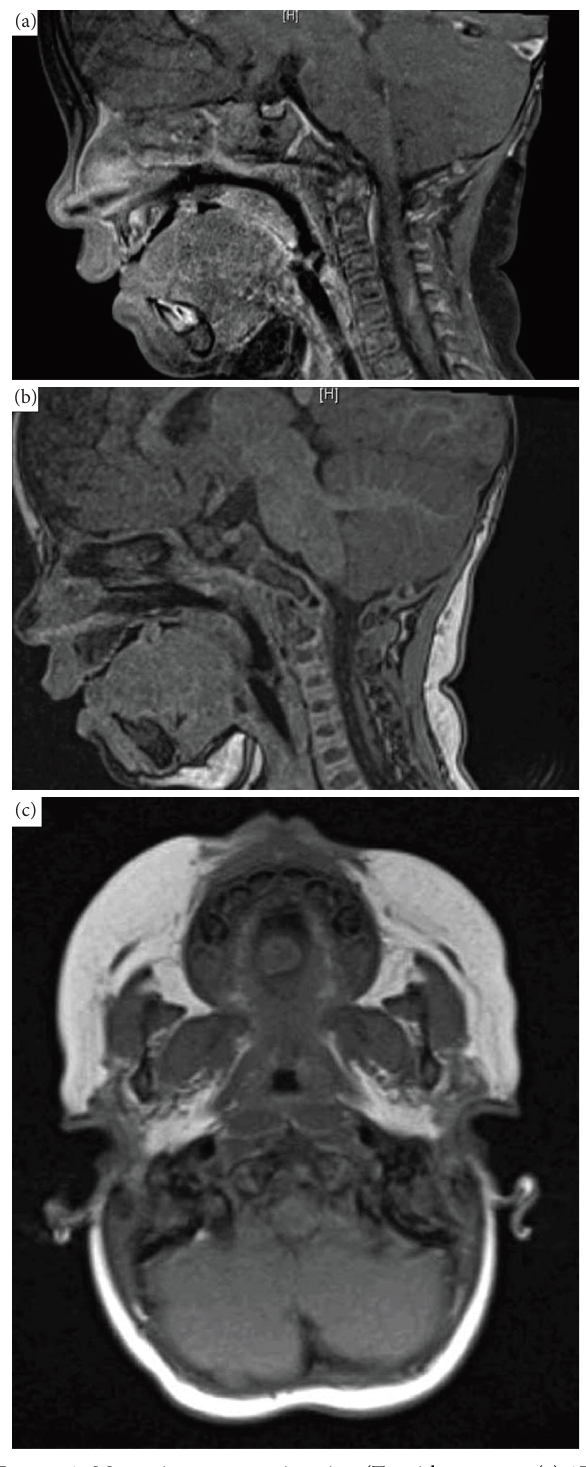
Figure 2: Magnetic resonance imaging (T1 with contrast, (a) 3D MPRAGE, (b) T1 without contrast), and (c) of the head demon- strating a polypoid dorsal midline lingual